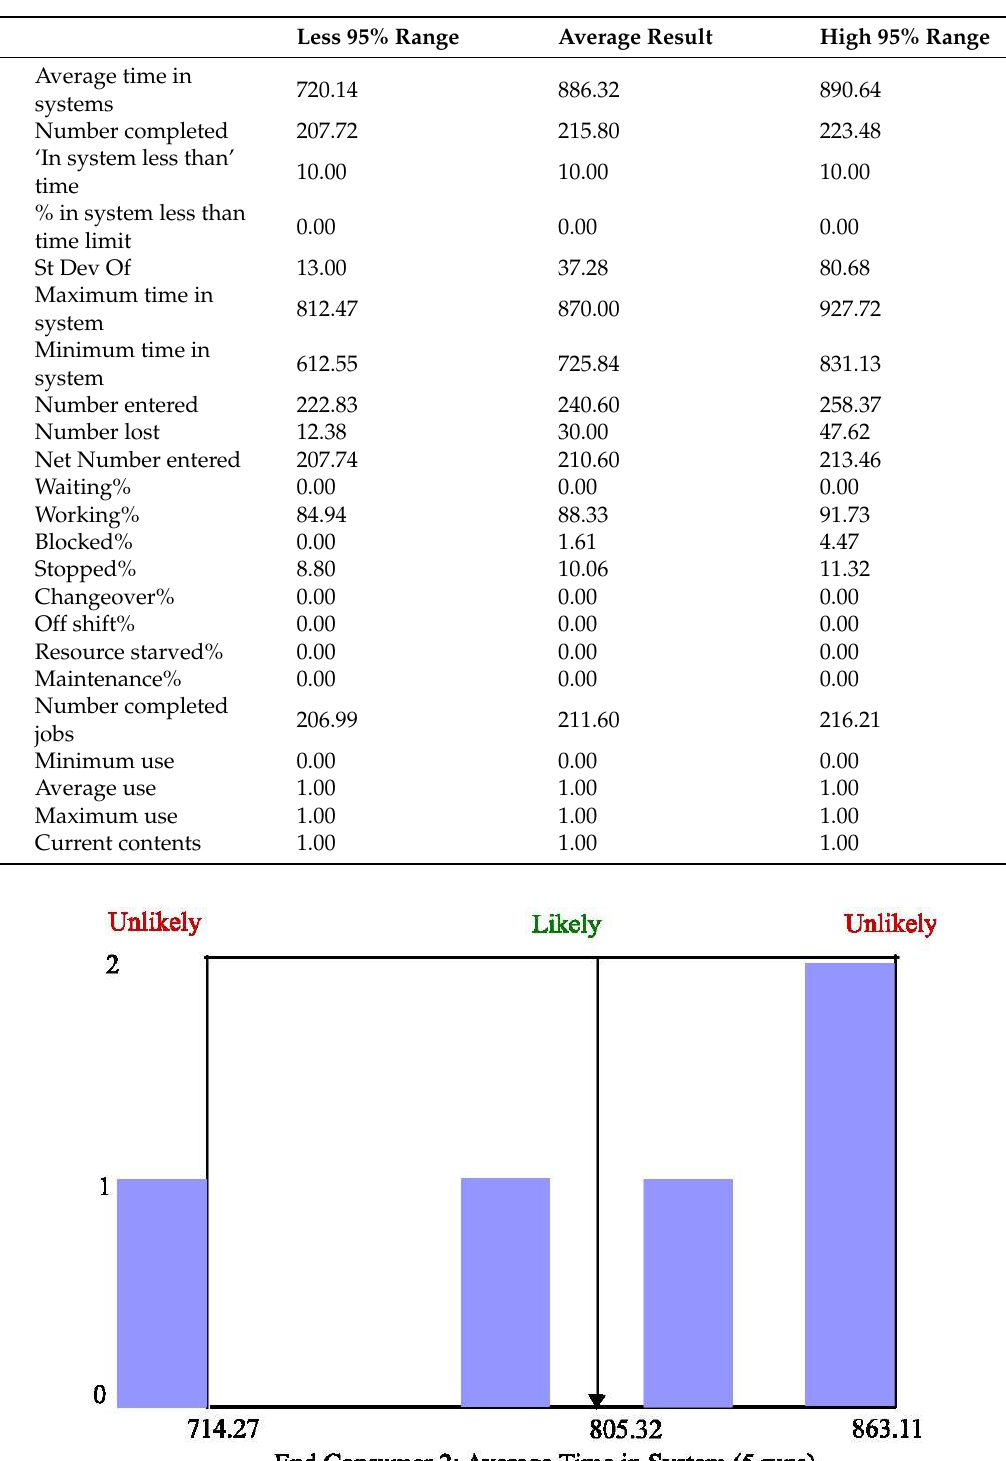
Figure 9. MORE plot for working% in packaging and storage in stage 2. 4.2. ‘What-If’ Scenario Analysis—Scenario 1 and 2 Process Model Comparison The simulated model in Figure 10 depicts a comparison between the two scenarios simulated in the Simul8 software. In scenario 1, the human workforce alone manages and executes the tasks for beef supply chain operations at all stages. In scenario 2, Robotic Process Automation, along with fewer humans in the workforce, operates tasks with greater efficiency and less time taken. In scenario 1, the average time taken for carcass processing is 995.28 min (16.5 h), whereas in scenario 2, the average time taken is 805.32 min (13.4 h). Scenario 2 uses RPA with a greater capacity and efficiency and reduces hu- man errors and risk factors. Beef nutritional value, hygiene, safety and traceability are greatly enhanced in scenario 2 due to the fast-paced production and beef processing at all stages in the supply chain. The working% in scenario 2 is 88.33, which is almost double the percentage in scenario 1.